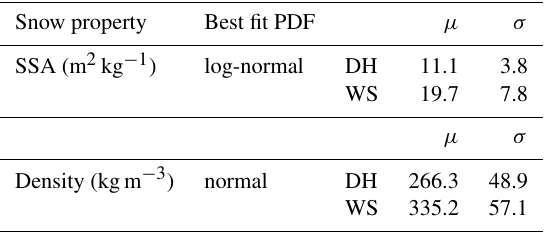
Table 5. Parameters for best fitting distribution of SSA and density for layers of DH and